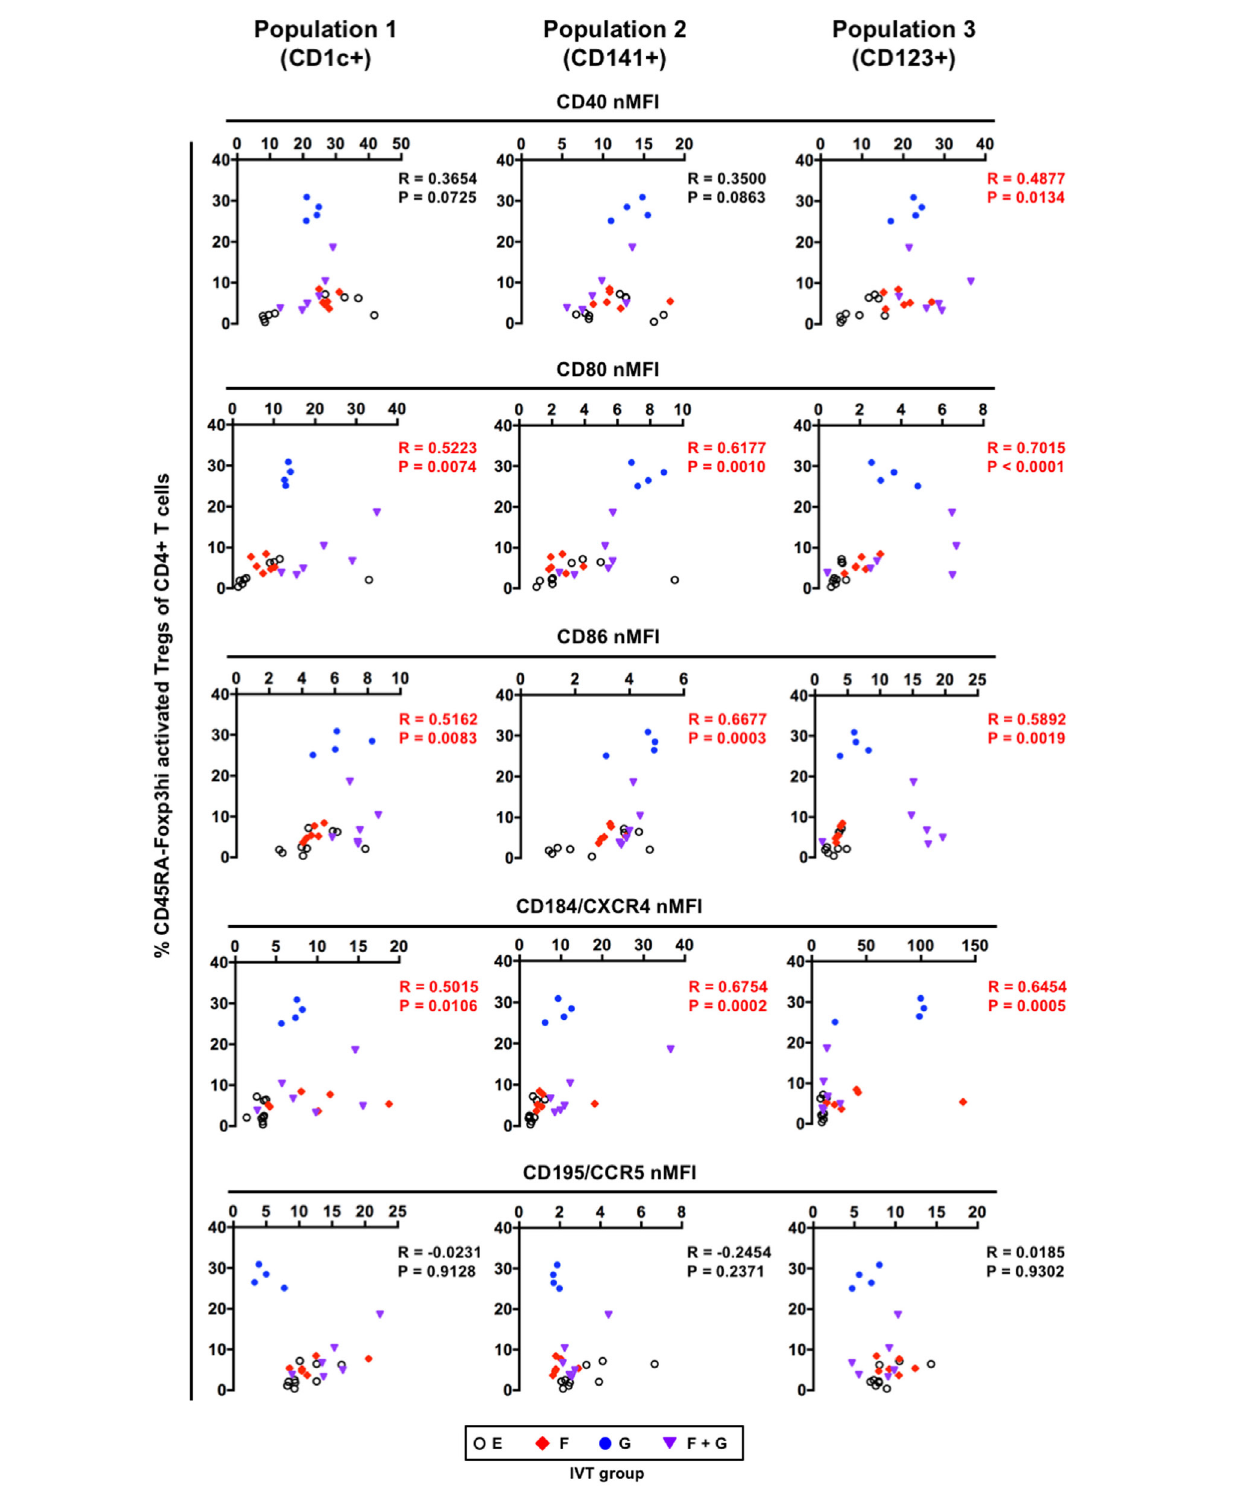
FigUre 9 | Correlation between the maturation status of putative dendritic cell populations and the development of CD45RA − Foxp3 hi activated regulatory T cells (Tregs). Individual normalized mean fluorescence intensity values for each maturation-associated marker in splenic CD1c + population (Population 1), CD141 + population (Population 2), and CD123 + population (Population 3) ( Figure 7b ), and the percentages of CD45RA − Foxp3 hi activated Tregs ( Figure 8b ) were plotted (total n = 25, consisting of Group E: n = 9; Group F: n = 6; Group G: n = 4; Group F + G: n = 6). The Spearman’s rank correlation coefficient was used for statistical analysis.